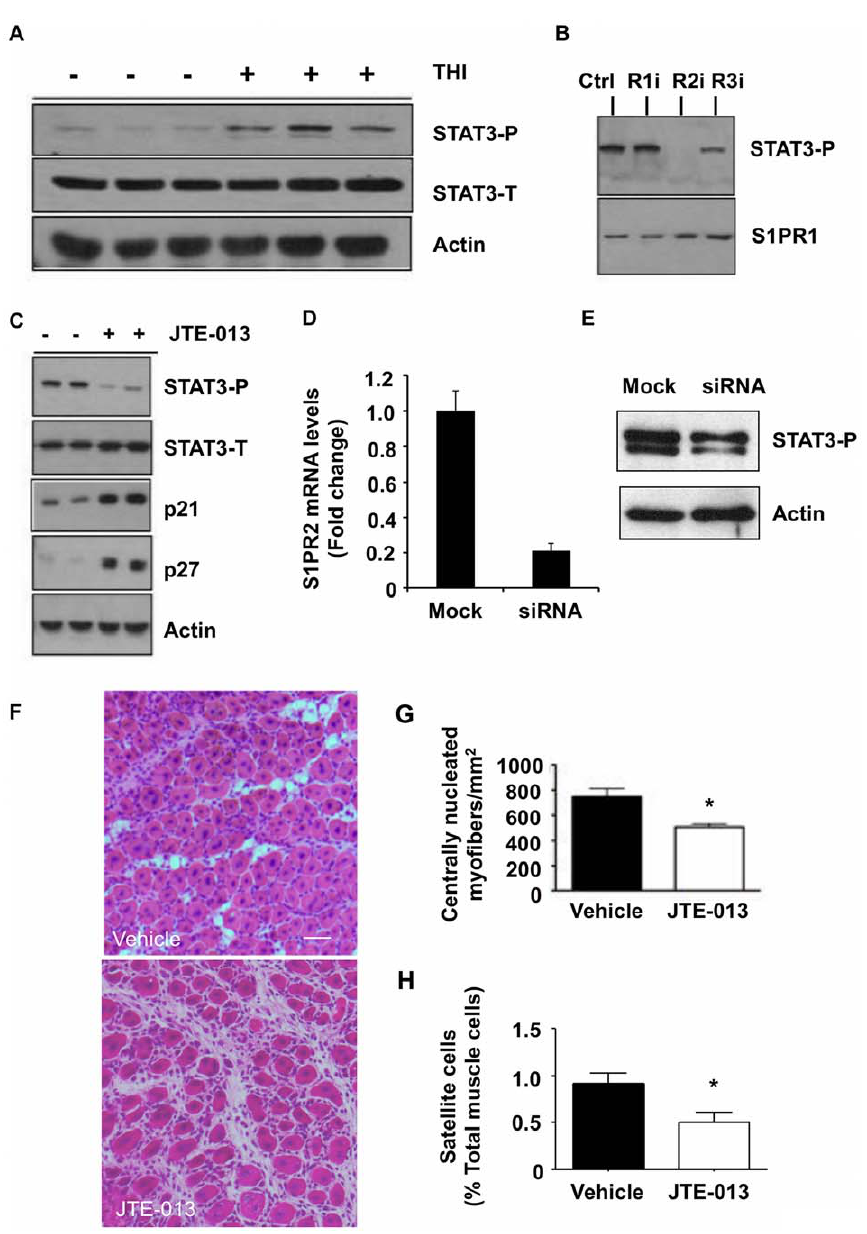
Figure 6. STAT3 and S1PR2 signaling interactions in muscle regeneration of WT and mdx mice. A) Mdx mice received NTX with or without THI treatment. Muscles were harvested on day 5 post-injury, and whole muscle extracts were examined for total STAT3 (STAT3-T) and phosphorylated STAT3 (STAT3-P) protein levels. Actin is used as a loading control. B) STAT3 activation in SC-derived myoblasts treated in vitro with 10 m M S1PR1 (R1i), S1PR2 (R2i), and S1PR3 (R3i) antagonists. S1PR1 is used as a loading control, as its expression is invariant under these conditions. C) WT SC-derived primary myoblasts were treated with S1PR2 antagonist (JTE-013) or vehicle, and whole cell extracts were examined for STAT3 phosphorylation, total STAT3 and p21 and p27 protein levels. Actin is used as a loading control. D) SC-derived primary myoblasts were treated with either 50 nM siRNA against S1PR2 or mock transfection. S1PR2 knockdown was confirmed by qRT-PCR. E) Whole cell extracts of control and S1PR2 knockdown cells were examined for phosphorylated STAT3 and actin protein levels by immunoblotting. p=0.03 (siRNA vs. mock) for relative densitometric levels of STAT3-P/actin from two experiments performed in duplicates. F) WT mice were treated with NTX plus antagonist of S1PR2 (JTE-013) or vehicle by subcutaneous injection. Muscles were harvested 5 days post injury; regenerating fibers were imaged, and G) regenerating fibers were quantified. H) Flow cytometry analysis of SCs from WT mice treated with JTE-013 or vehicle at 5 days post injury; * indicates p # 0.05, data are means 6 SD,